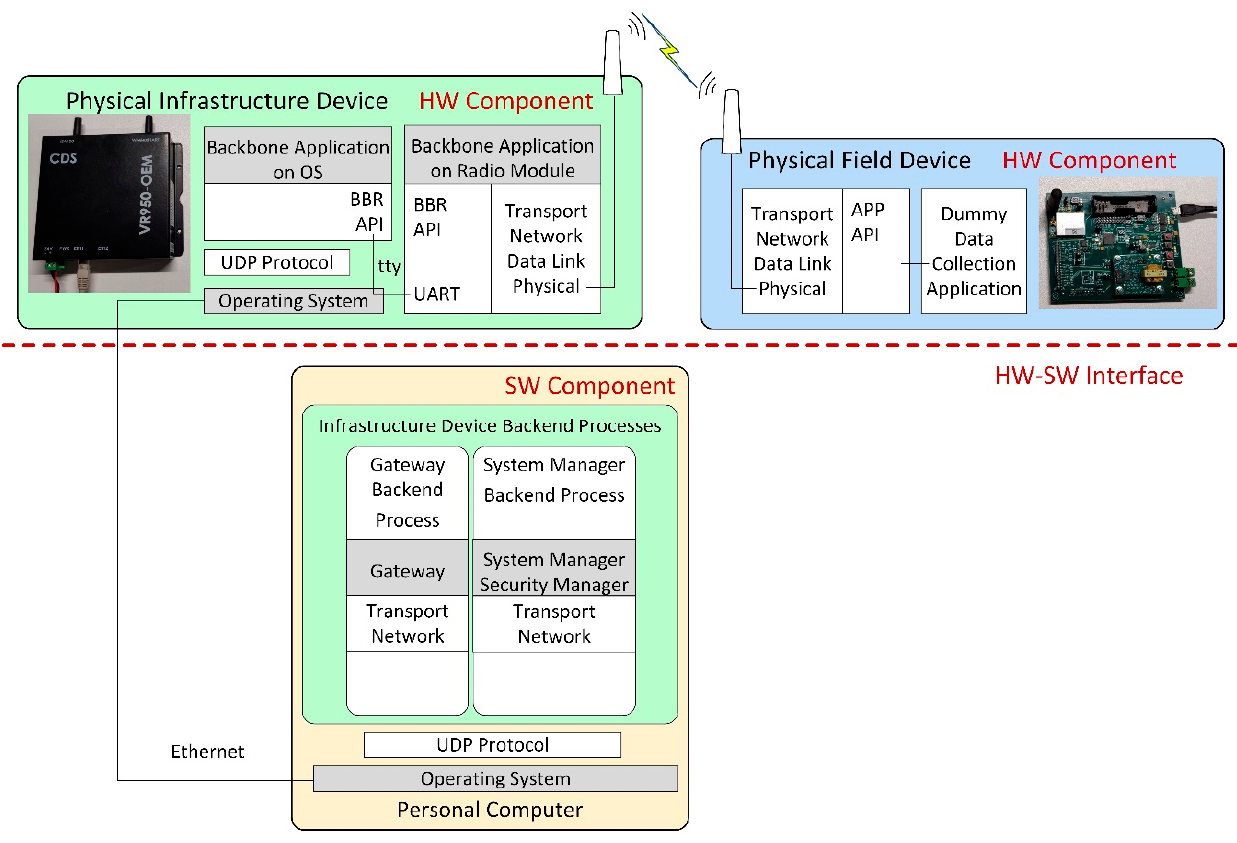
Figure 7. Node-in-the-loop scenario architecture.